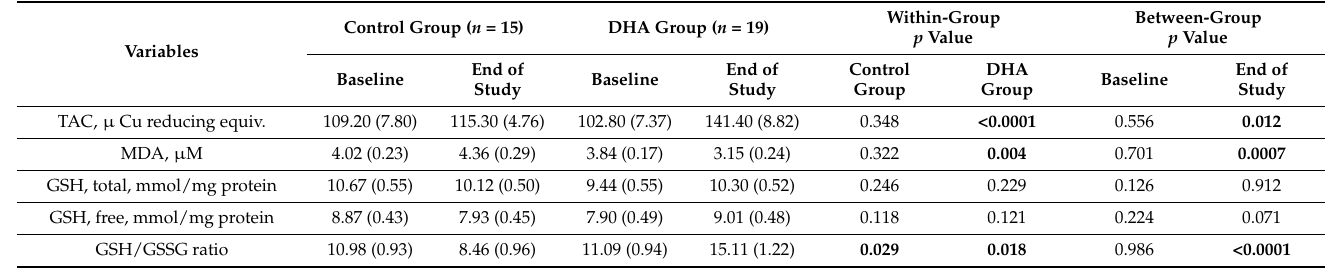
Table 4. Antioxidant variables at baseline and at the end of the study in patients treated with the DHA supplement and in controls.